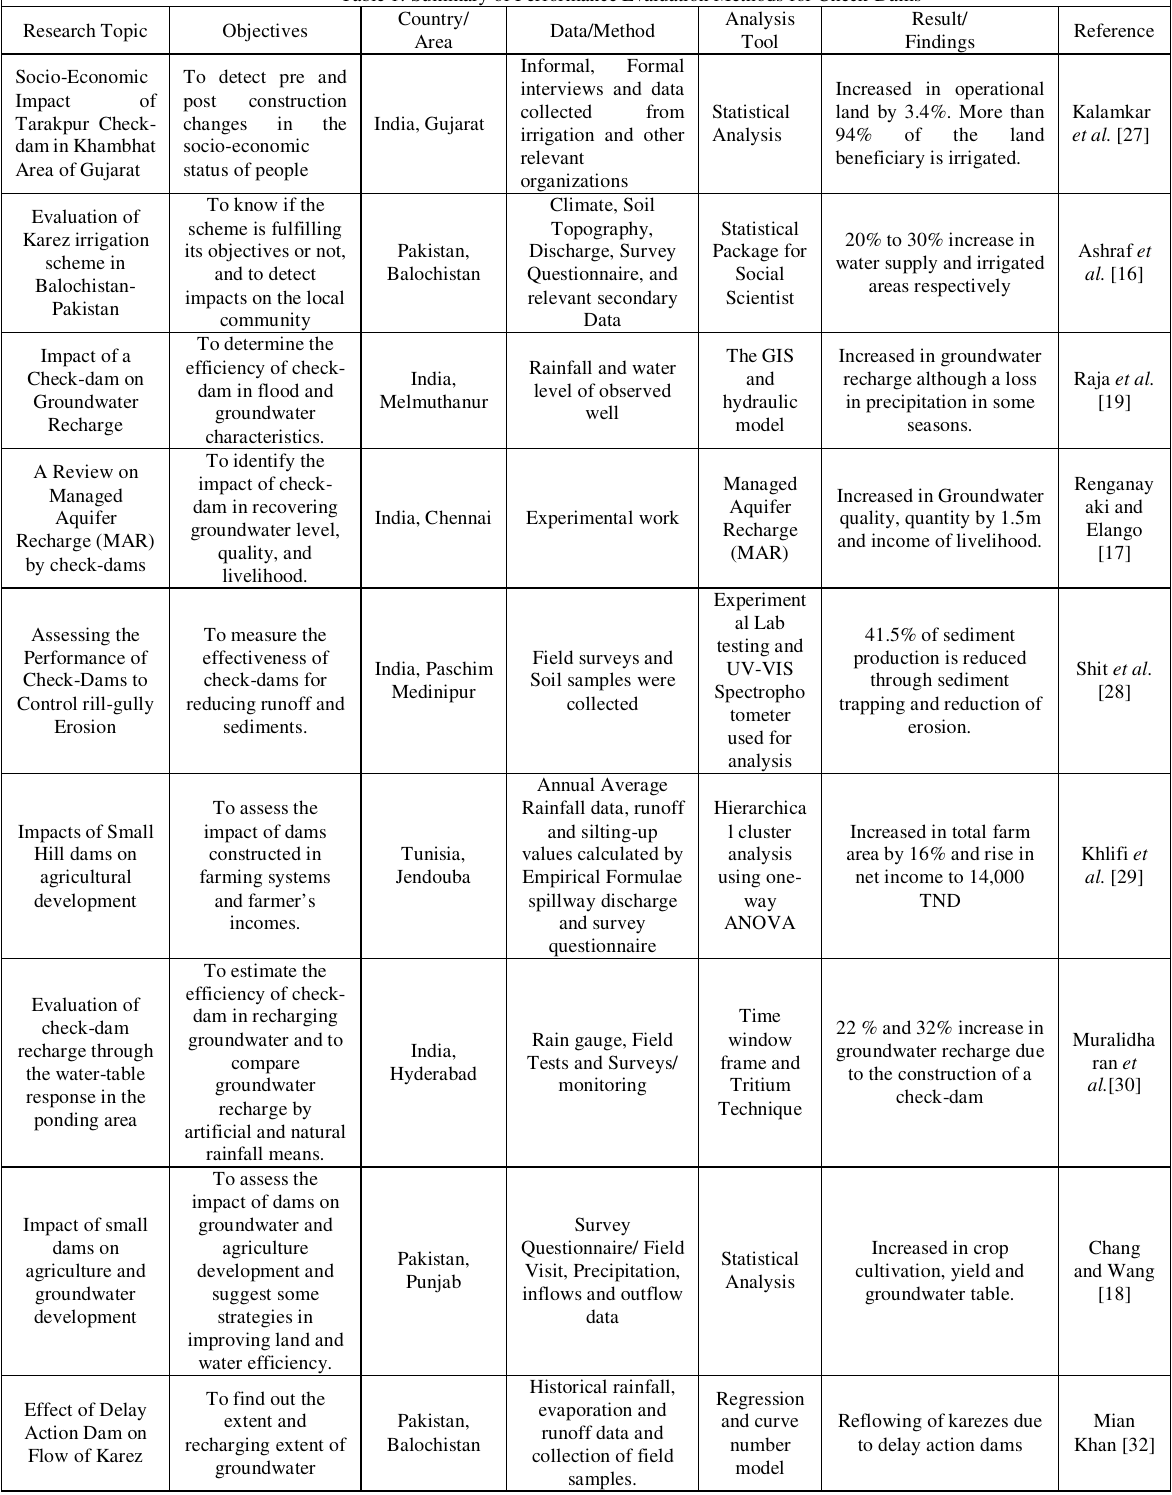
Table 1: Summary of Performance Evaluation Methods for